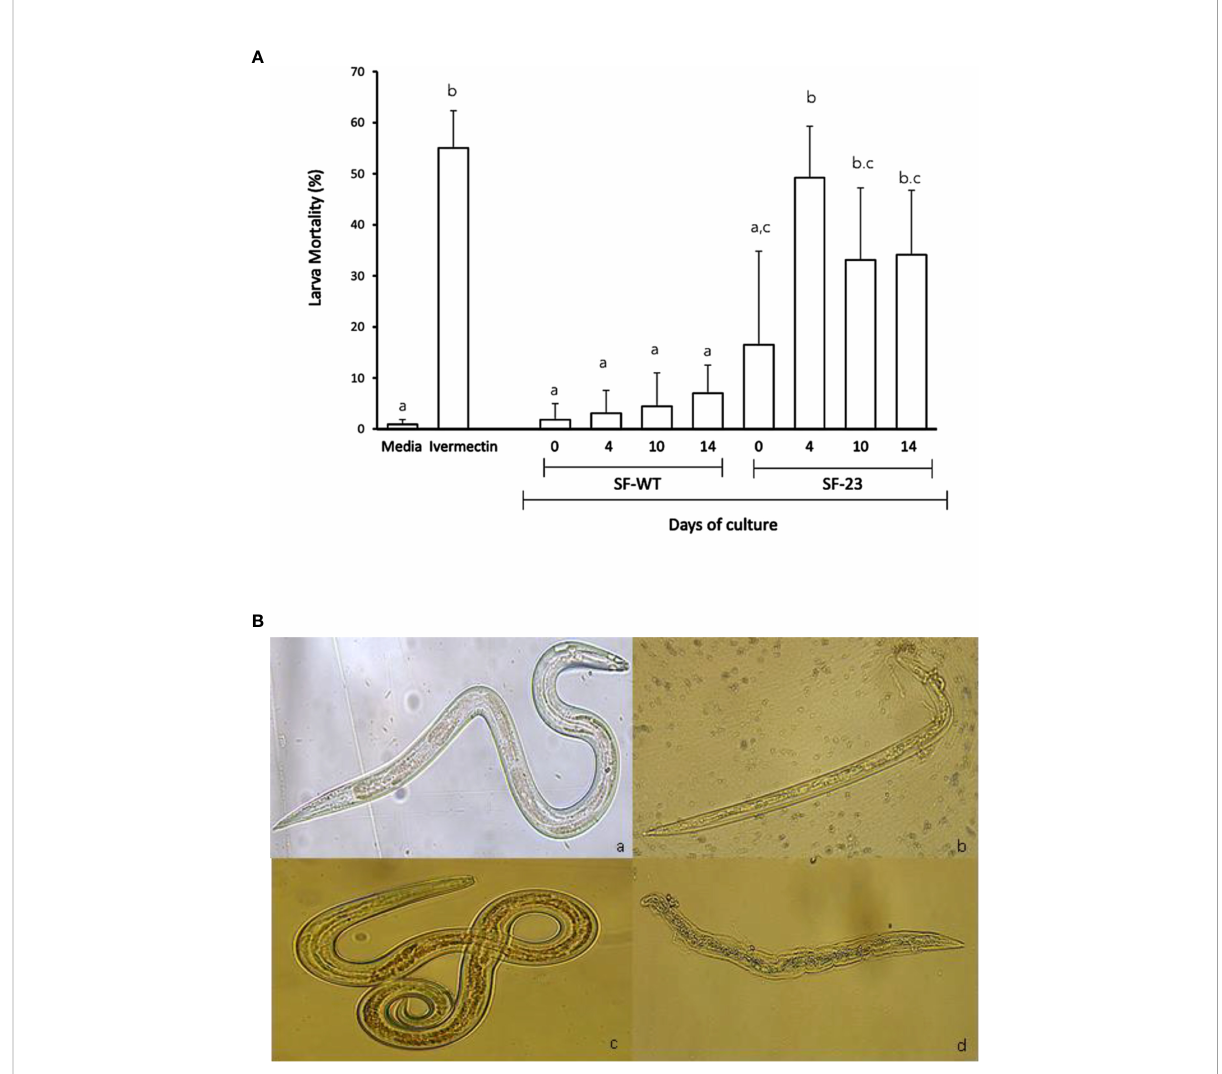
FIGURE 5 Larval damage induced after 72 h of in vitro culture. (A) Mortality percentage (mean ± SD) of L 4 H. contortus larvae exposed to 1 mg/ml of C. papaya SF-WT and SF-23 cell line extracts sampled at different times of cell suspension culture (0, 4, 10, and 14 days). Larvae cultured in medium alone were included as a negative control, and Ivermectin was used as a positive control. Letters indicate signi fi cantly differences ( P < 0.05) in Tukey ’ s test. (B) Representative images of L 4 H. contortus larvae treated with (a) Hanks ’ medium (4X), (b) Ivermectin (10X), (c) SF-WT cell line (14 days) (20X), and (d) SF-23 cell line (14 days)